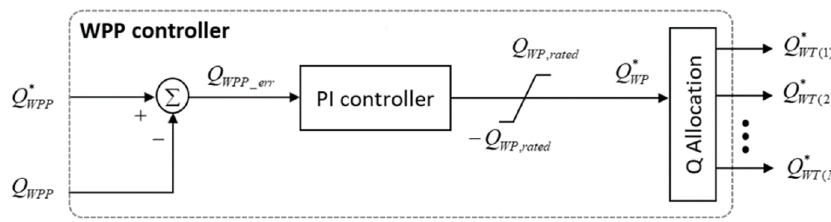
Figure 3. Block diagram for reactive power control of wind power plant [16,17].